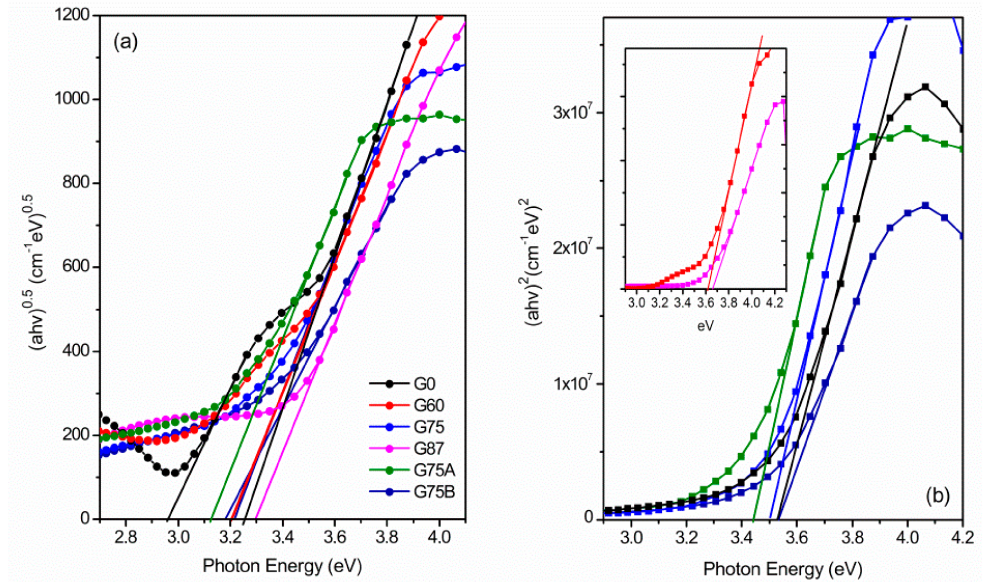
Figure 4. Tauc plots for the estimation of ( a ) indirect band gap and ( b ) direct band gap of the TiO 2